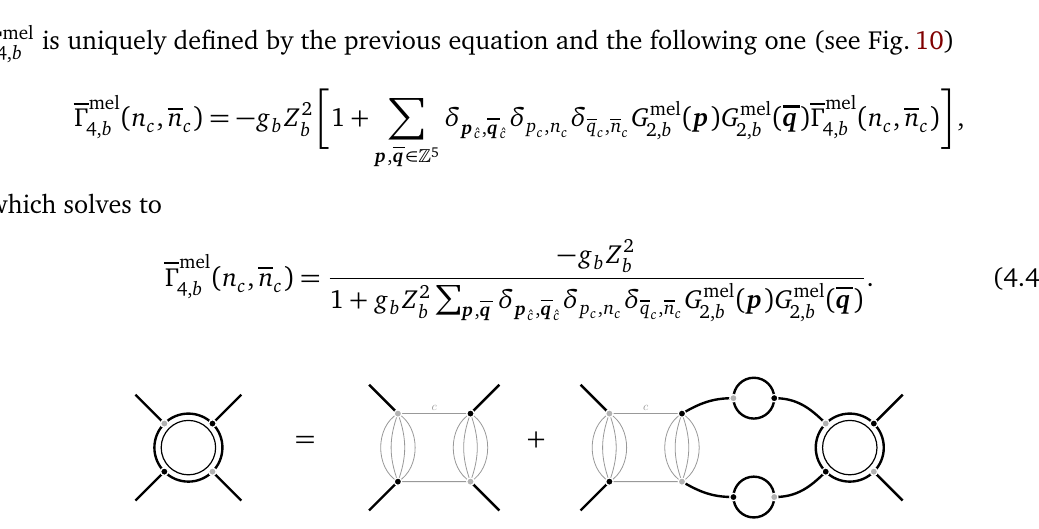
mel and G mel 4, b 2, b